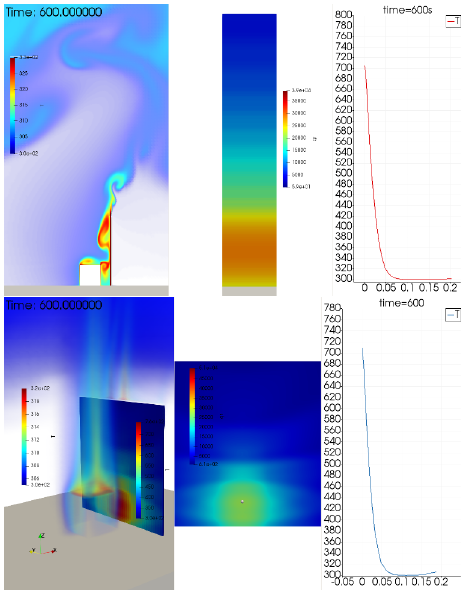
Fig. 2. Heated cube, simulation in 2D and 3D. (From left) The air temperature, the heat flux between the wall and the cube and the distribution of the temperature through the heated wall at time instance 600 s